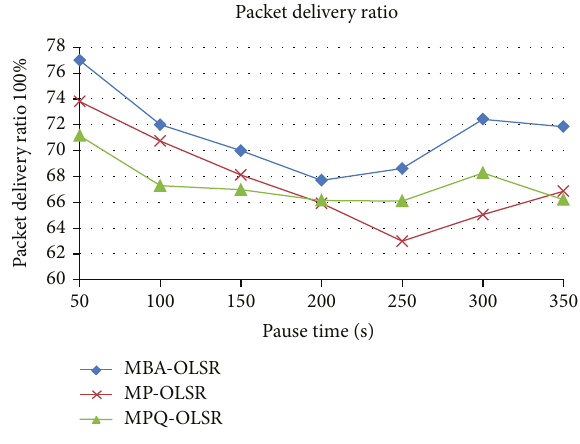
Figure 6: Packet delivery ratio for varying pause time. Table 2: Number of dead nodes for varying pause